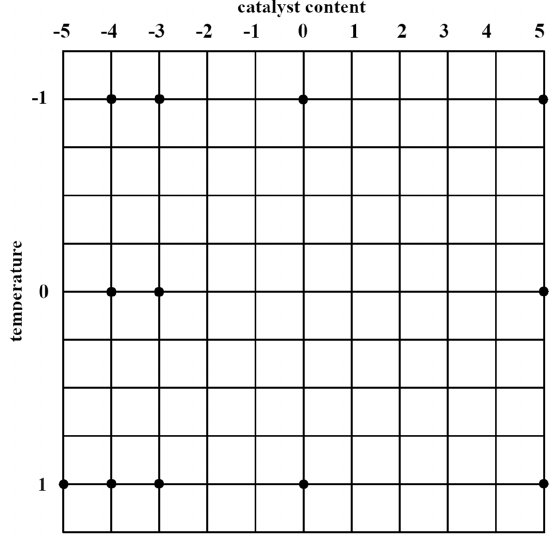
Figure 6. The selection of input variables by magic squares various methods. Table 3. The comparison of the optimization results (exp.) with calculated values (cal.) derived from the analysis of the synthesis